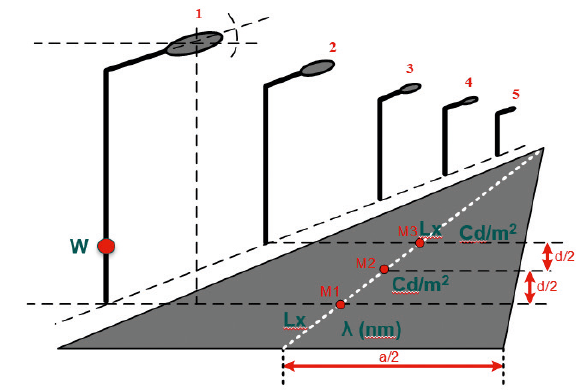
a) Measurement points of street profiles